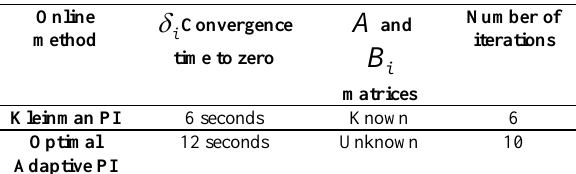
i   trajectories under Figure 5. Agents , 1 ,..., 5 i unknown dynamics. Table 1. Online PI methods comparison under known and unknown